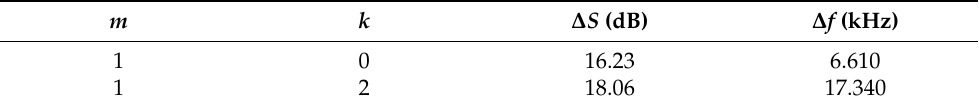
two different sets of